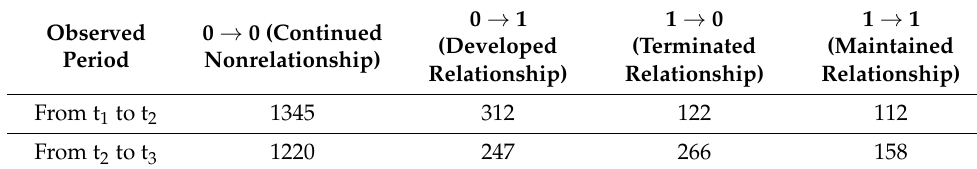
Table 2. Changes in policy communication networks among Ki-no-Eki organizations between subse- quent observations.